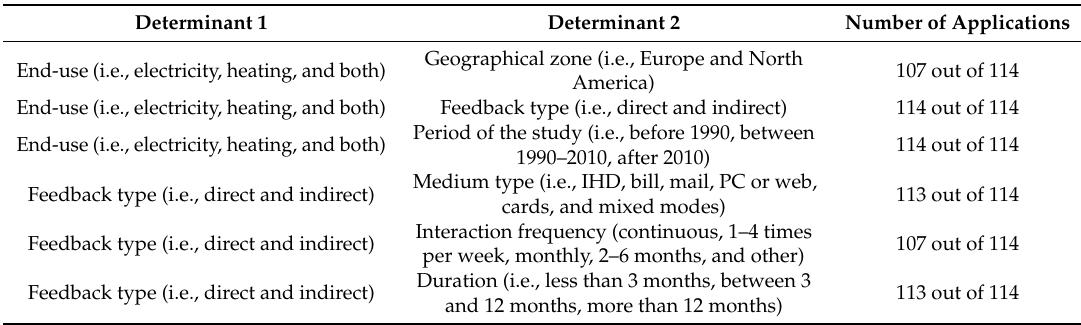
Table 1. Combinations of determinants used to provide statistics on energy savings associated to feedback strategies.